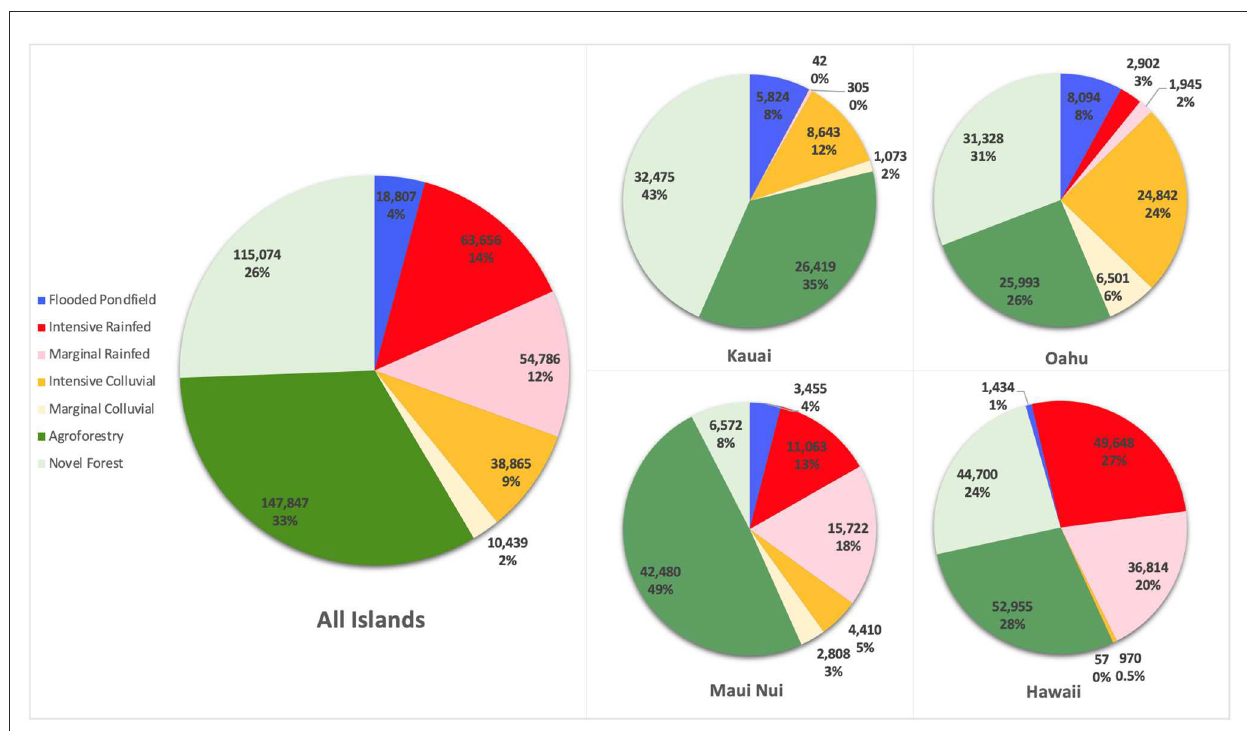
FIGURE2 The percent contribution to the agricultural potential for each agroecological archetype by island and for the archipelago as a whole. Maui Nui combines Maui with the three smaller surrounding islands of Moloka’i, L¯ana’i, and Kaho’olawe.